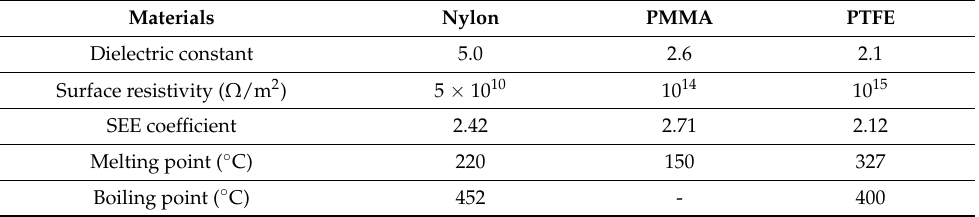
Table 1. Main physical properties of Nylon, PMMA, and PTFE.